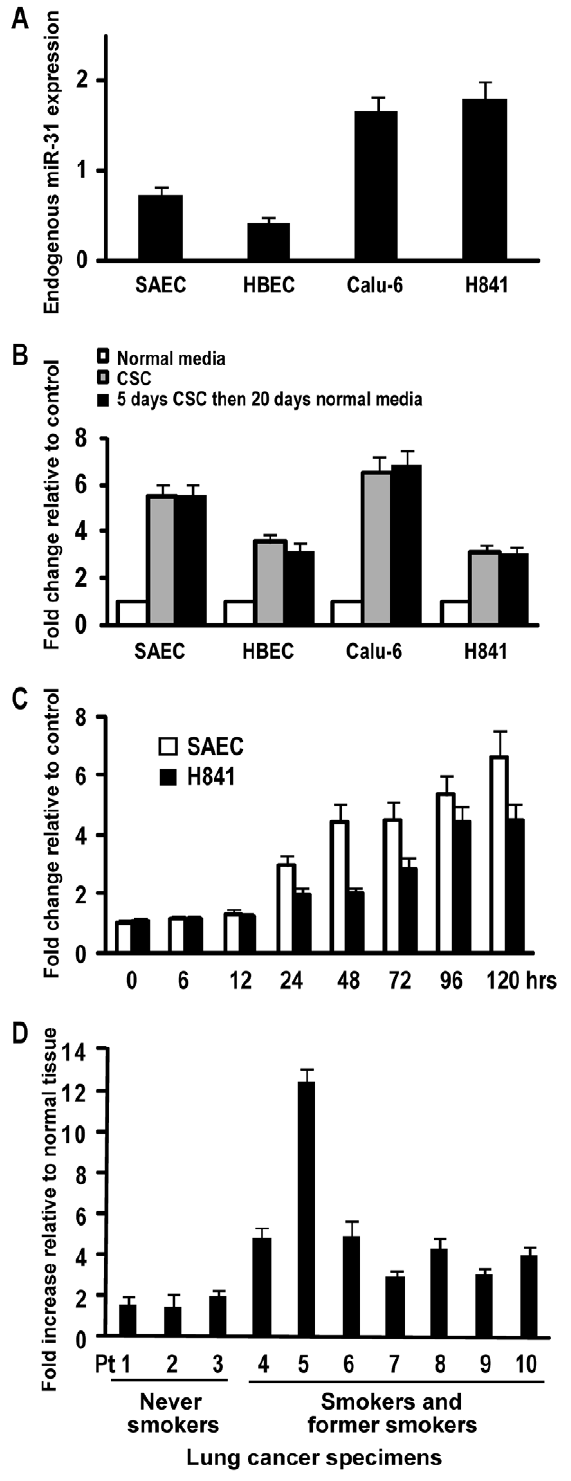
Figure 1. Expression of miR-31 in cultured cells exposed to CSC, primary lung cancers and adjacent normal lung tissues. A) qRT-PCR analysis of endogenous miR-31 expression normalized with control miRNA (RNU44) in SAEC, HBEC, Calu-6, and H841cells. Basal levels of miR-31 are higher in lung cancers relative to cultured normal or immortalized human respiratory epithelial cells. B) qRT-PCR analysis of miR-31 expression in SAEC, HBEC, Calu-6, and H841cells cultured in normal media (NM) with or without CSC for 5 days. Increased miR-31